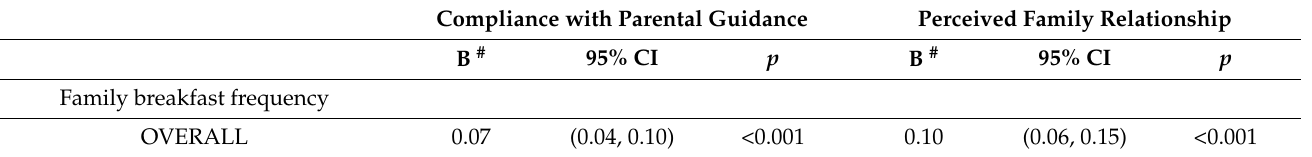
Kong (Compliance: in Hong Kong B = 0.07, p < 0.001 vs. outside Hong Kong B = 0.08,